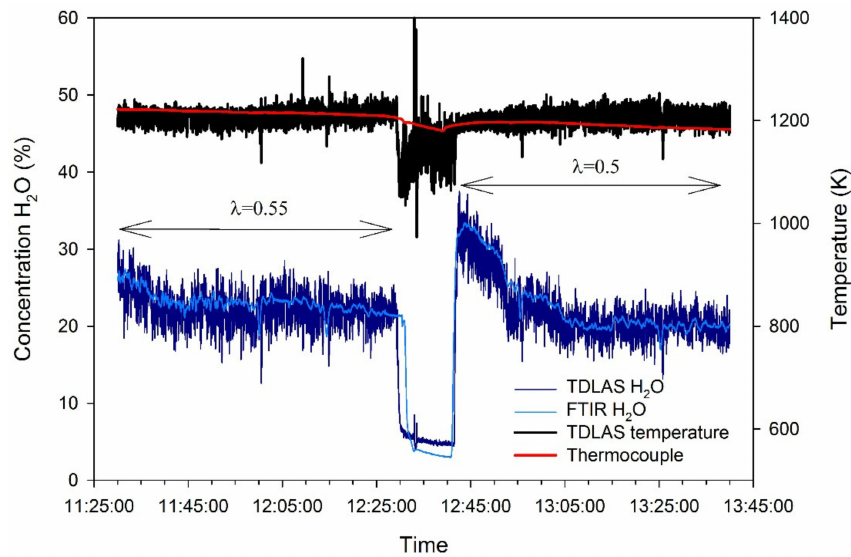
Figure 8. The real-time measurements of H 2 O by the TDLAS (tunable diode laser absorption spectroscopy) and FTIR (Fourier-transform infrared spectroscopy) and the temperature measured by TDLAS and thermocouple (type S). The data in the graph were acquired during gasification of hardwood for two equivalence ratios and the char combustion in